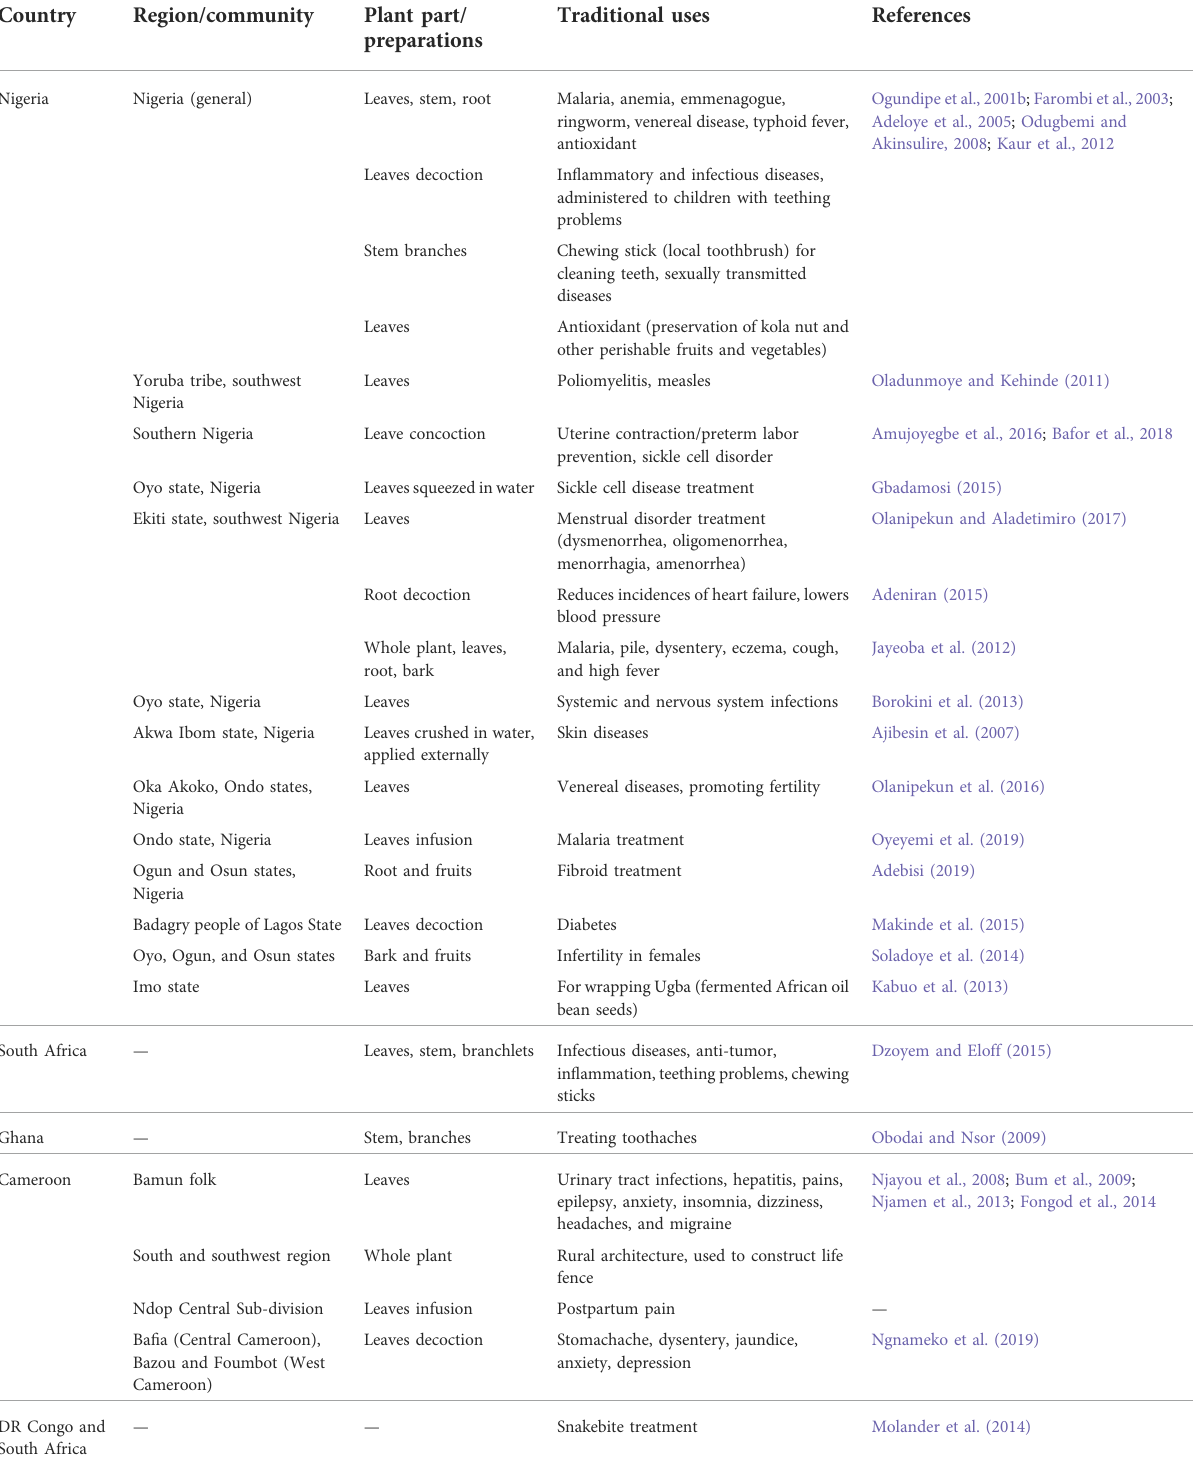
TABLE 1 Traditional uses of A. laxi fl ora in different African countries.